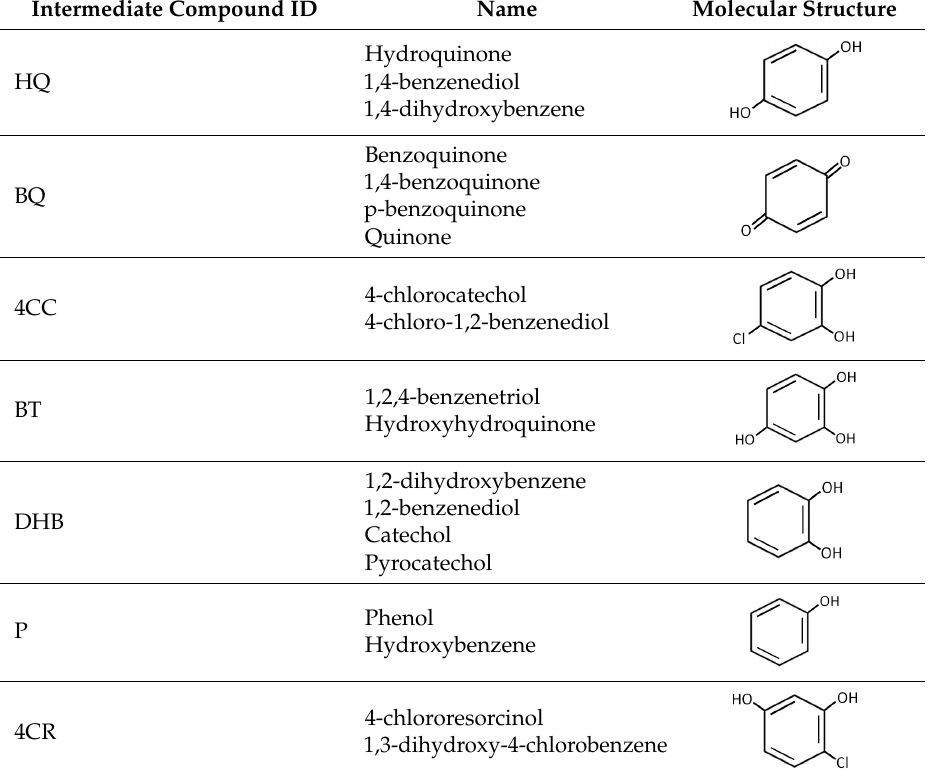
Figure 15. Proposed photocatalytic degradation pathway of 4-chlorophenol by W-Mo-TiO 2 .